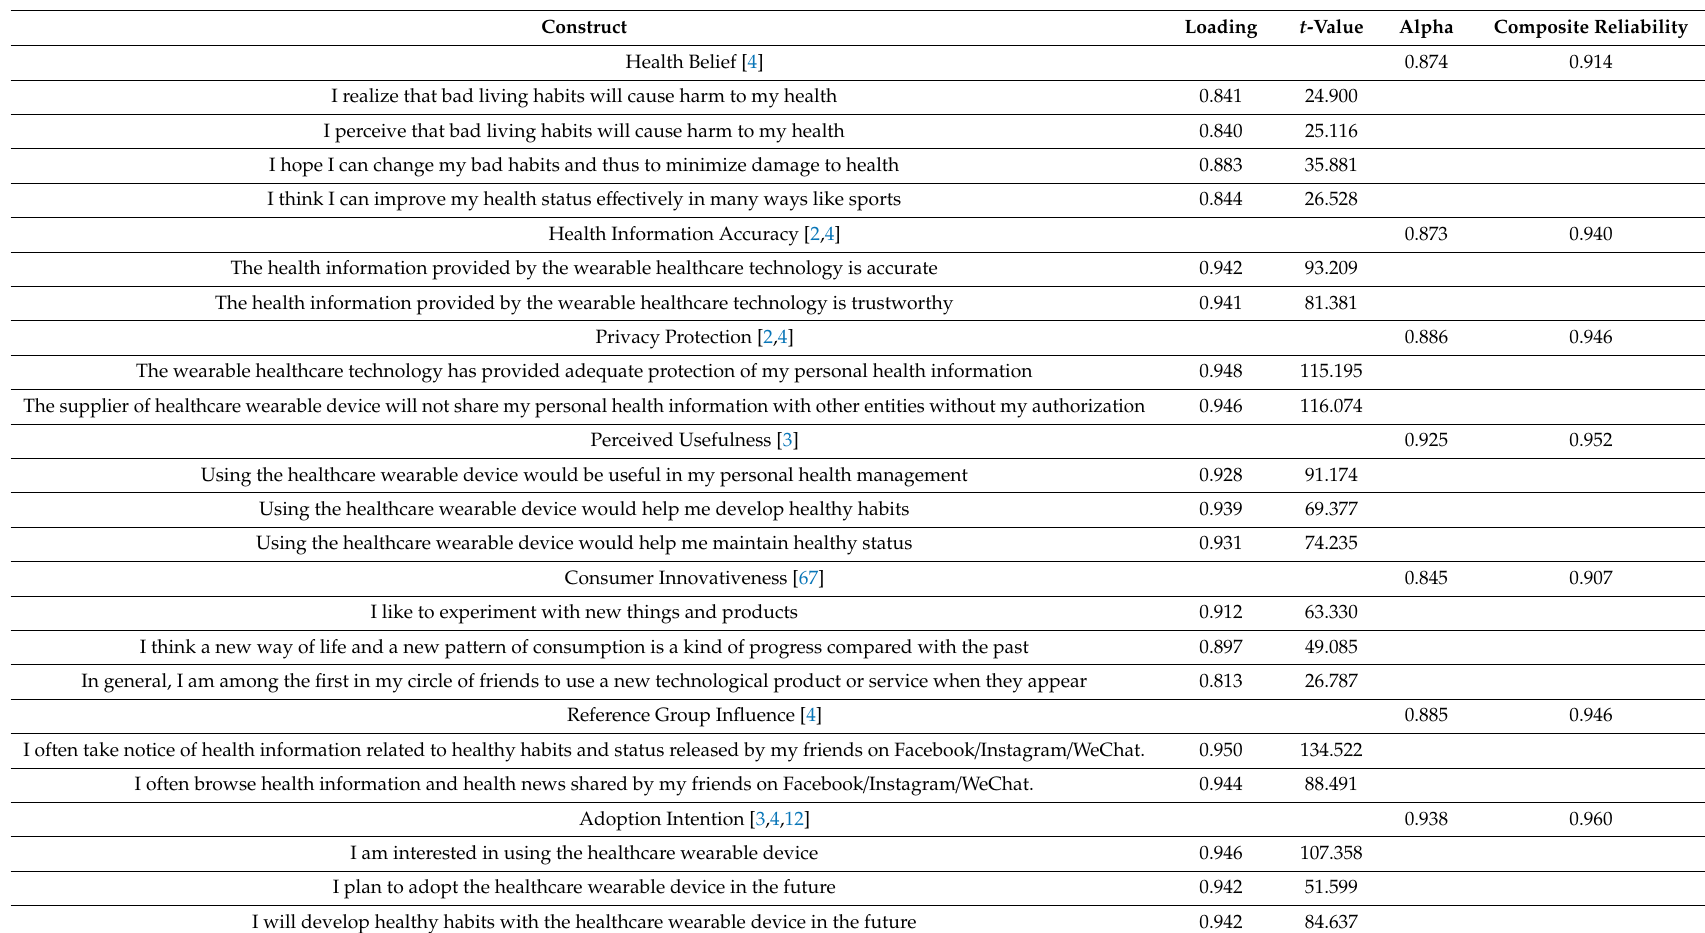
Table 1. Outer model